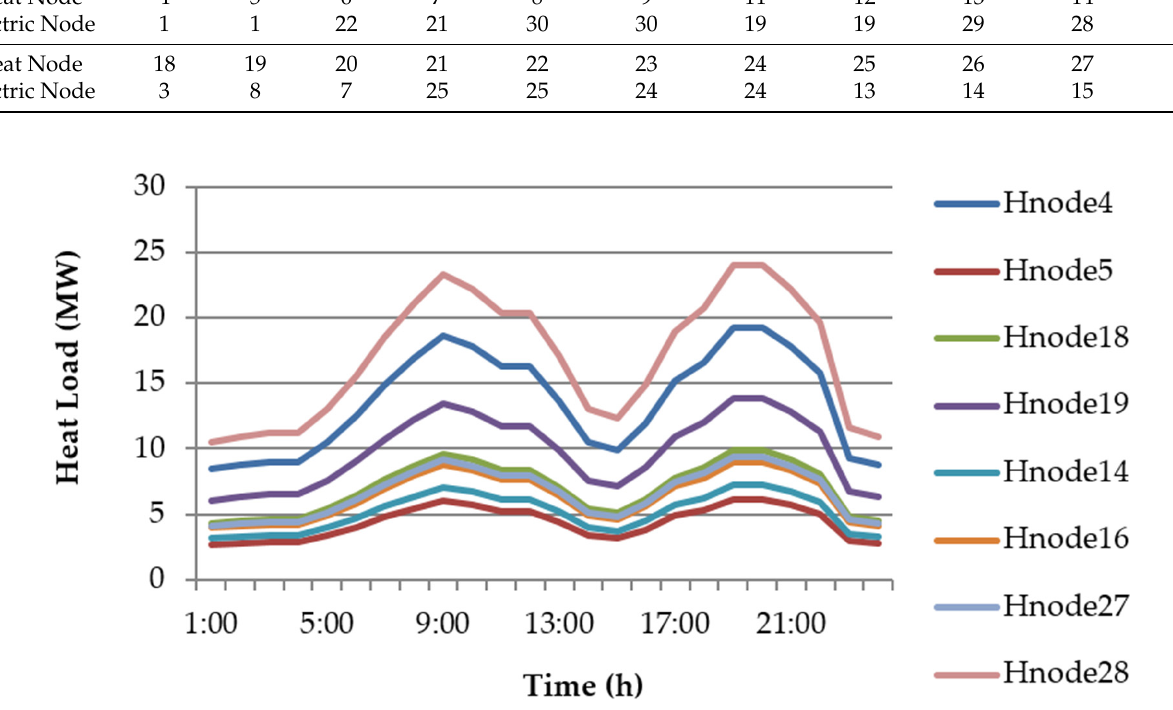
Figure A1. Commercial building heat load.